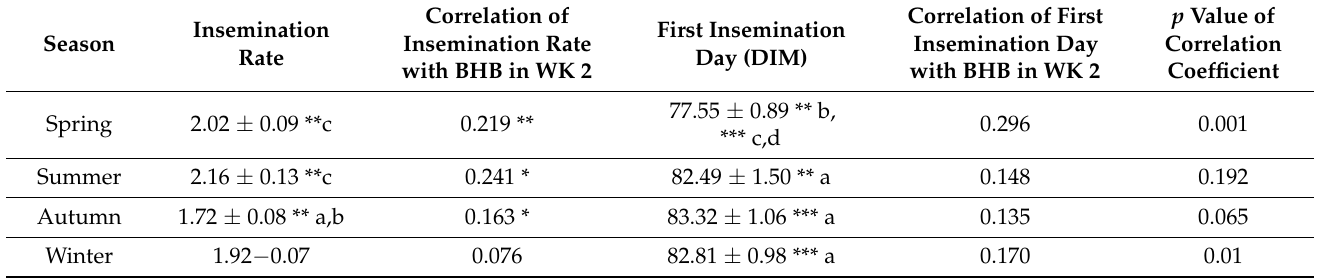
Table 3. The results of insemination rate and first insemination day in different seasons and rela- tionship between insemination rate and BHB concentration and first insemination day and BHB concentration.